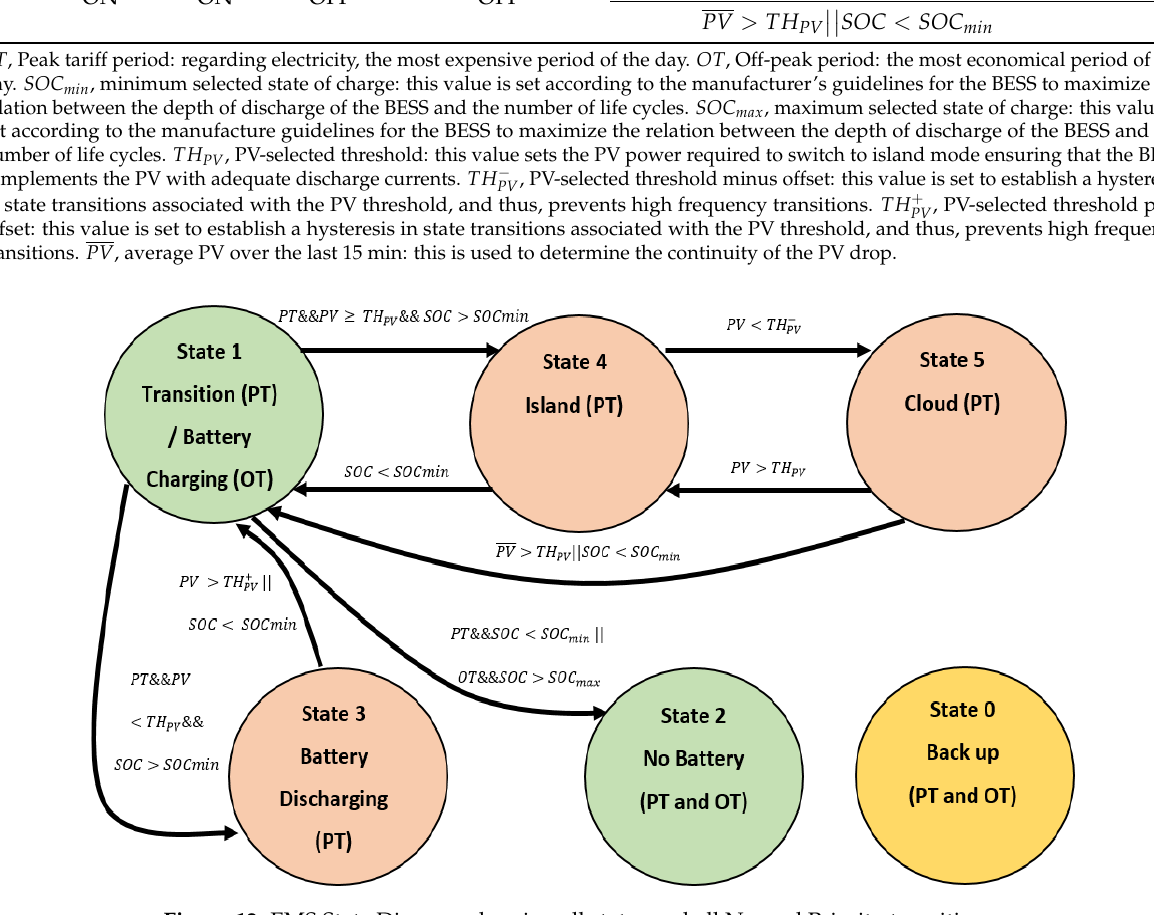
Figure 12. EMS State Diagram showing all states and all Normal Priority transitions.